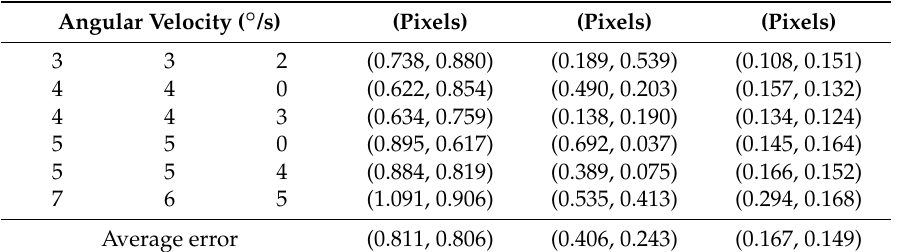
Table 1. Average centroid position error after reconstruction with different blur kernels.